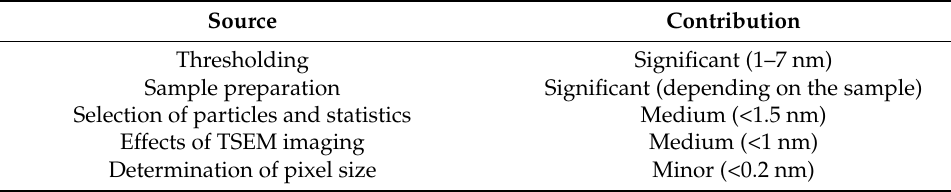
Table 4. Main uncertainty sources for NP size measurements by TSEM.